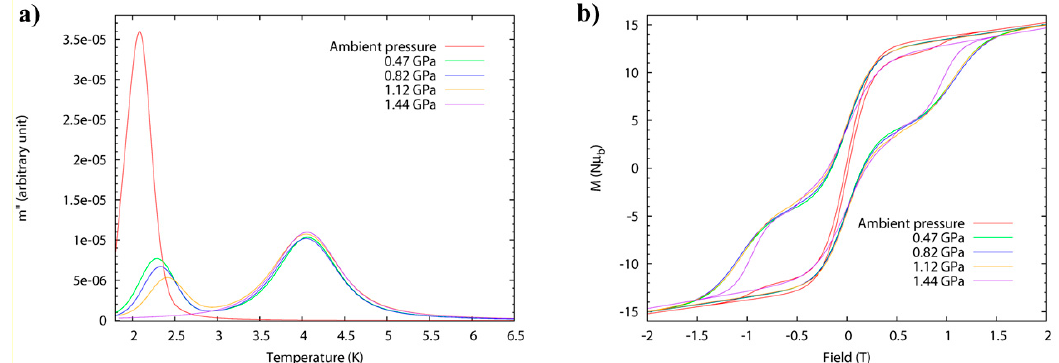
Figure 7. ( a ) High-pressure ac susceptibility data for compound 4 measured at a fixed frequency of